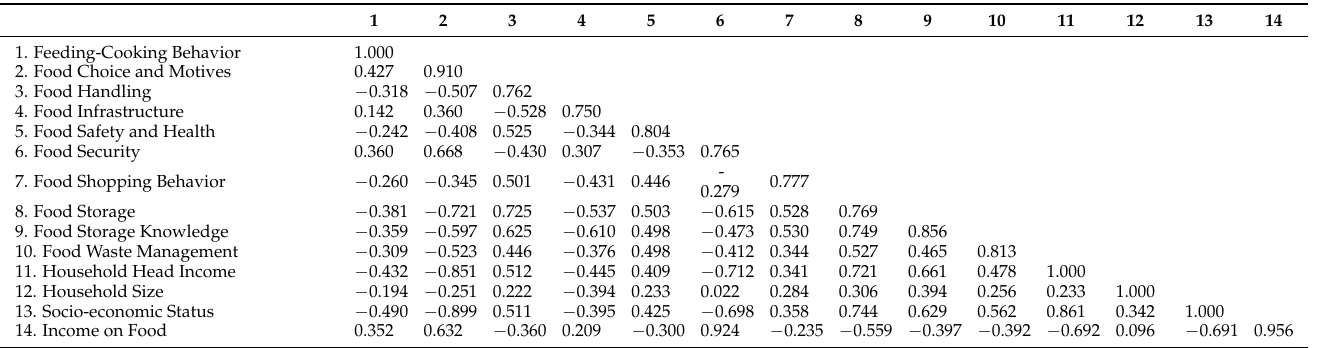
Table 10. Relationship between determinants of food storage, practices and outcomes (Fornell– Larcker